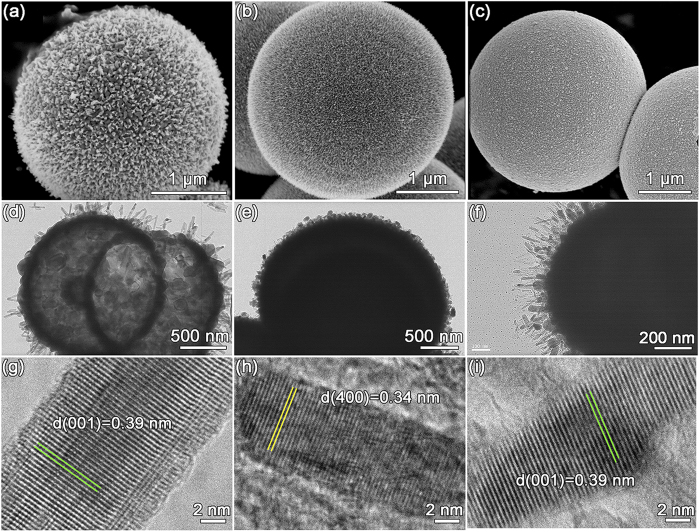
SEM, TEM and HR-TEM images of o-Nb2O5 hollow microspheres (a,d,g), t-NbO2@carbon core-shell microspheres (b,e,h) and o-Nb2O5@carbon core-shell microspheres (c,f,i).